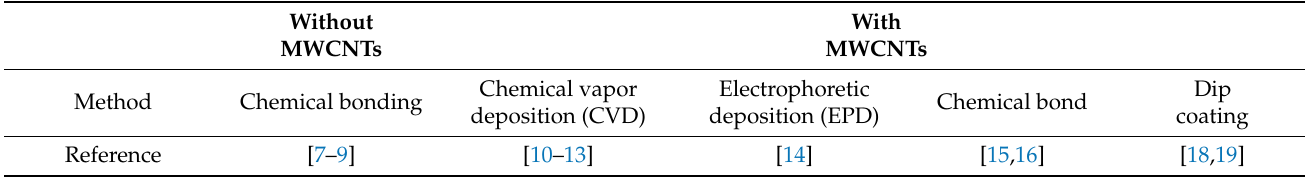
Table 1. Surface modification using MWCNTs on